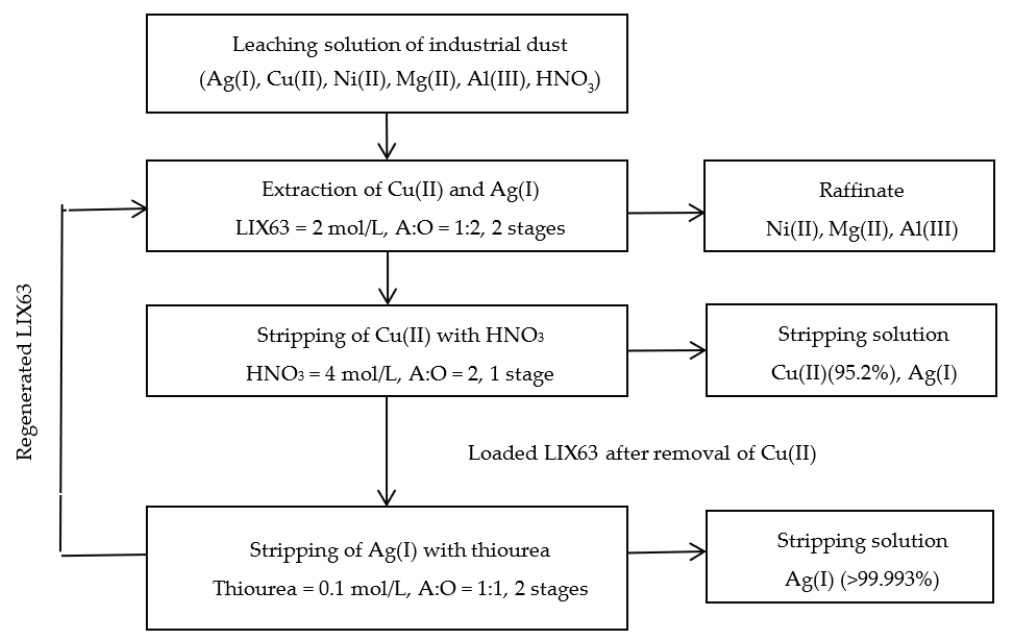
Figure 9. Flow chart of the proposed process for the separation of Cu(II) and Ag(I) from a nitrate leaching solution of industrial dust.